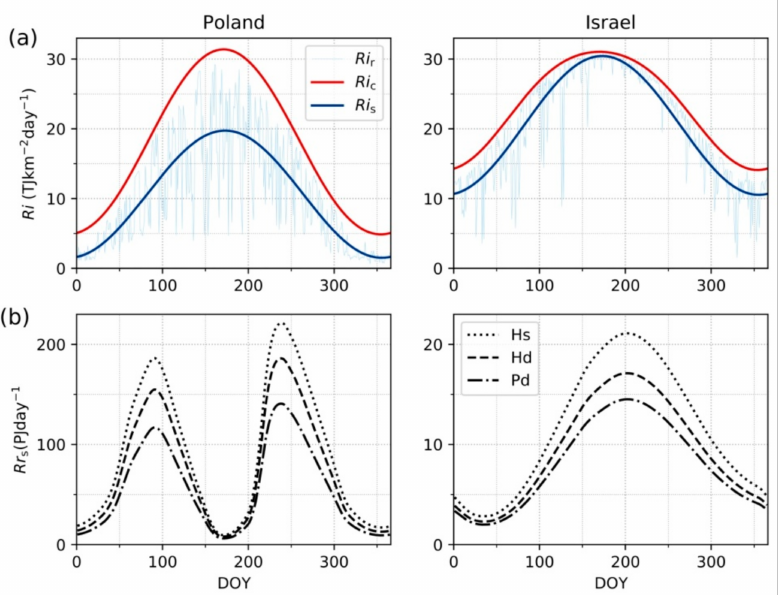
Figure 6. Annual variations in 2014 in: ( a ) real daily amount of shortwave radiation ( R ir ) and averaged (smoothed by Equation (5)) real amount of shortwave radiation ( Ri s ) reaching Poland and Israel against the background of corresponding value calculated for perfectly clear-sky conditions ( Ri c ); ( b ) smoothed real daily amount of shortwave radiation reflected from bare arable land ( Rr s ) in Poland and Israel, formed by a plow (P d ), a disk harrow (H d ), and a smooth harrow (H s ). Landsat scene numbers are 187/024 and 190/024 for Poland. Landsat scene numbers are 174/037 and 174/038 and 174/039 for